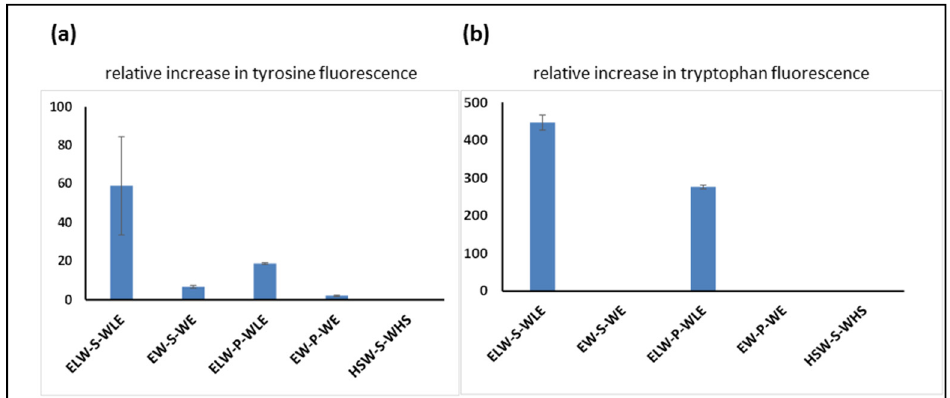
Figure 5. ( a ) Tyrosine fluorescence enhancement observed as a result of incubating cyclic peptide A at room temperature with the linear peptides shown. ( b ) Tryptophan fluorescence enhancement observed as a result of incubating cyclic peptide A at room temperature with the linear peptides shown.